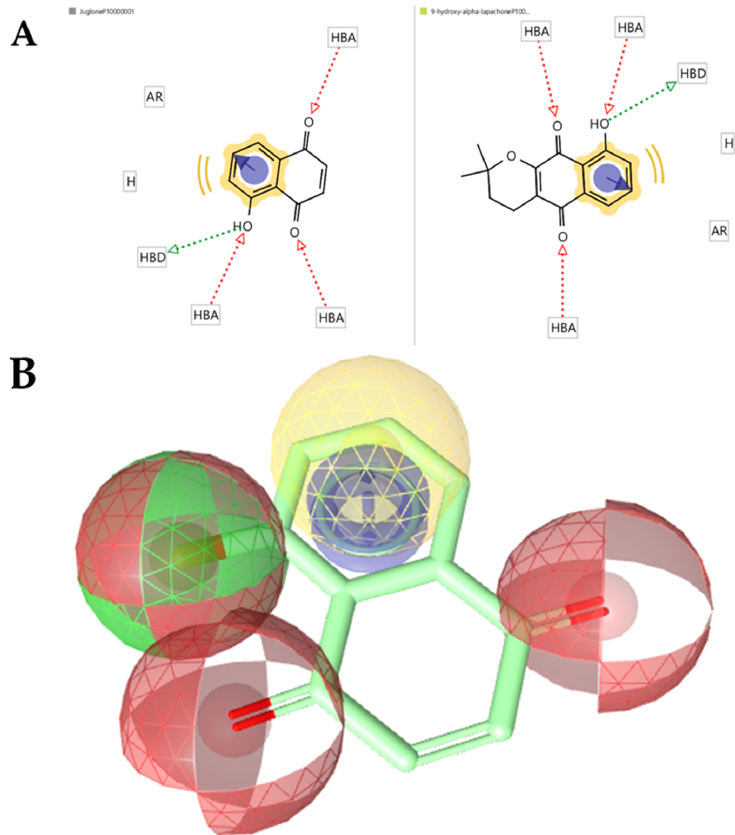
Figure 2. The pharmacophore features generated from the two inhibitors. ( A ) Juglone (left) and 9-hydroxy-lapachone (right) showing shared pharmacophoric features comprising Aromatic Rings (AR), Hydrogen Bond Donors (HBD), Hydrogen Bond Acceptors (HBA) and Hydrophobic interac- tions (H). ( B ) The actives and their overlapped pharmacophoric features which are represented in the pharmacophore model. The red balls show Hydrogen bond acceptors (HBA), the yellow ball shows Hydrophobic interactions, the green ball shows Hydrogen bond donors (HBD) and a blue ring represents an Aromatic ring.